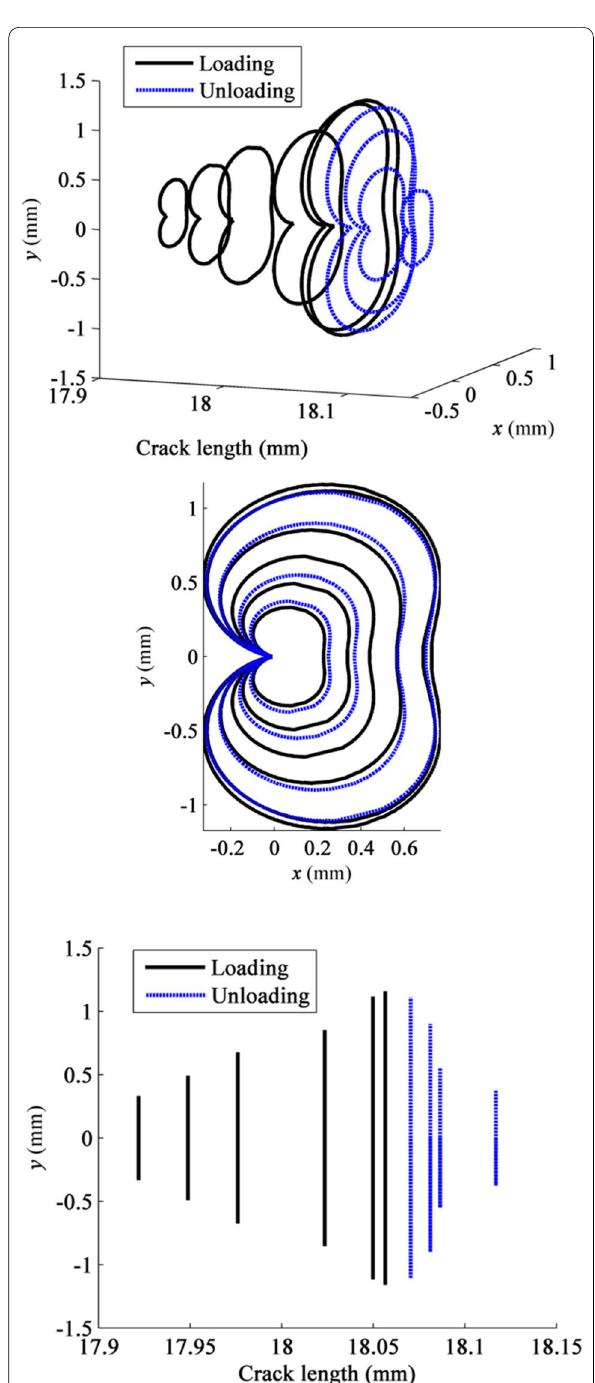
Figure 8 Theoretical evolution of plastic area during loading and